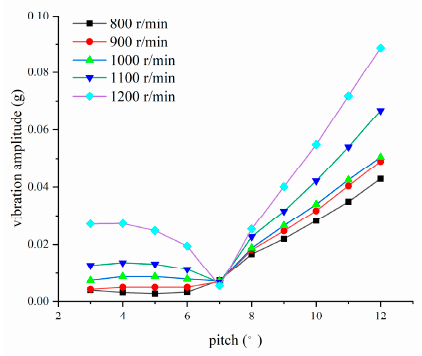
Figure 18. Lateral polar diagram of pitch.